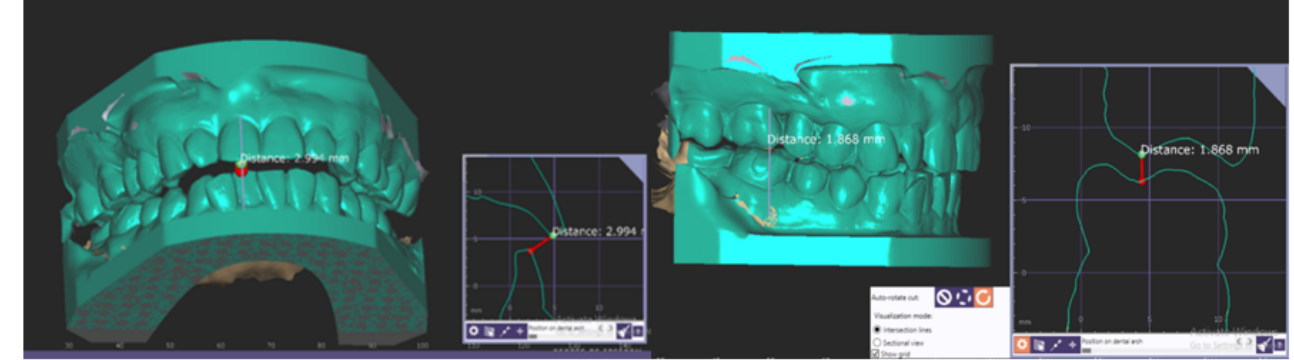
Figure 3. Anterior and posterior interocclusal measurements at OVD + 3 mm in the IOG.